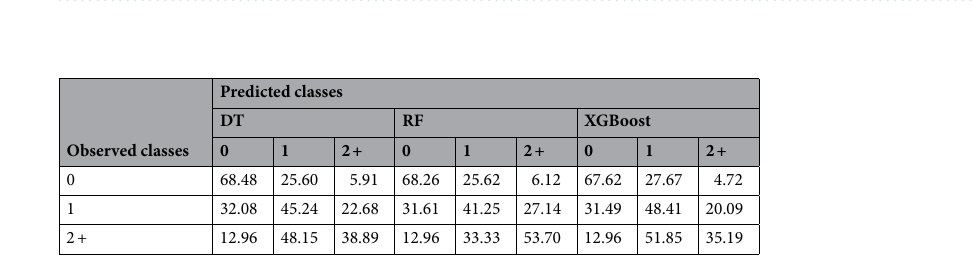
Table 6. Confusion matrix to present test results for all three